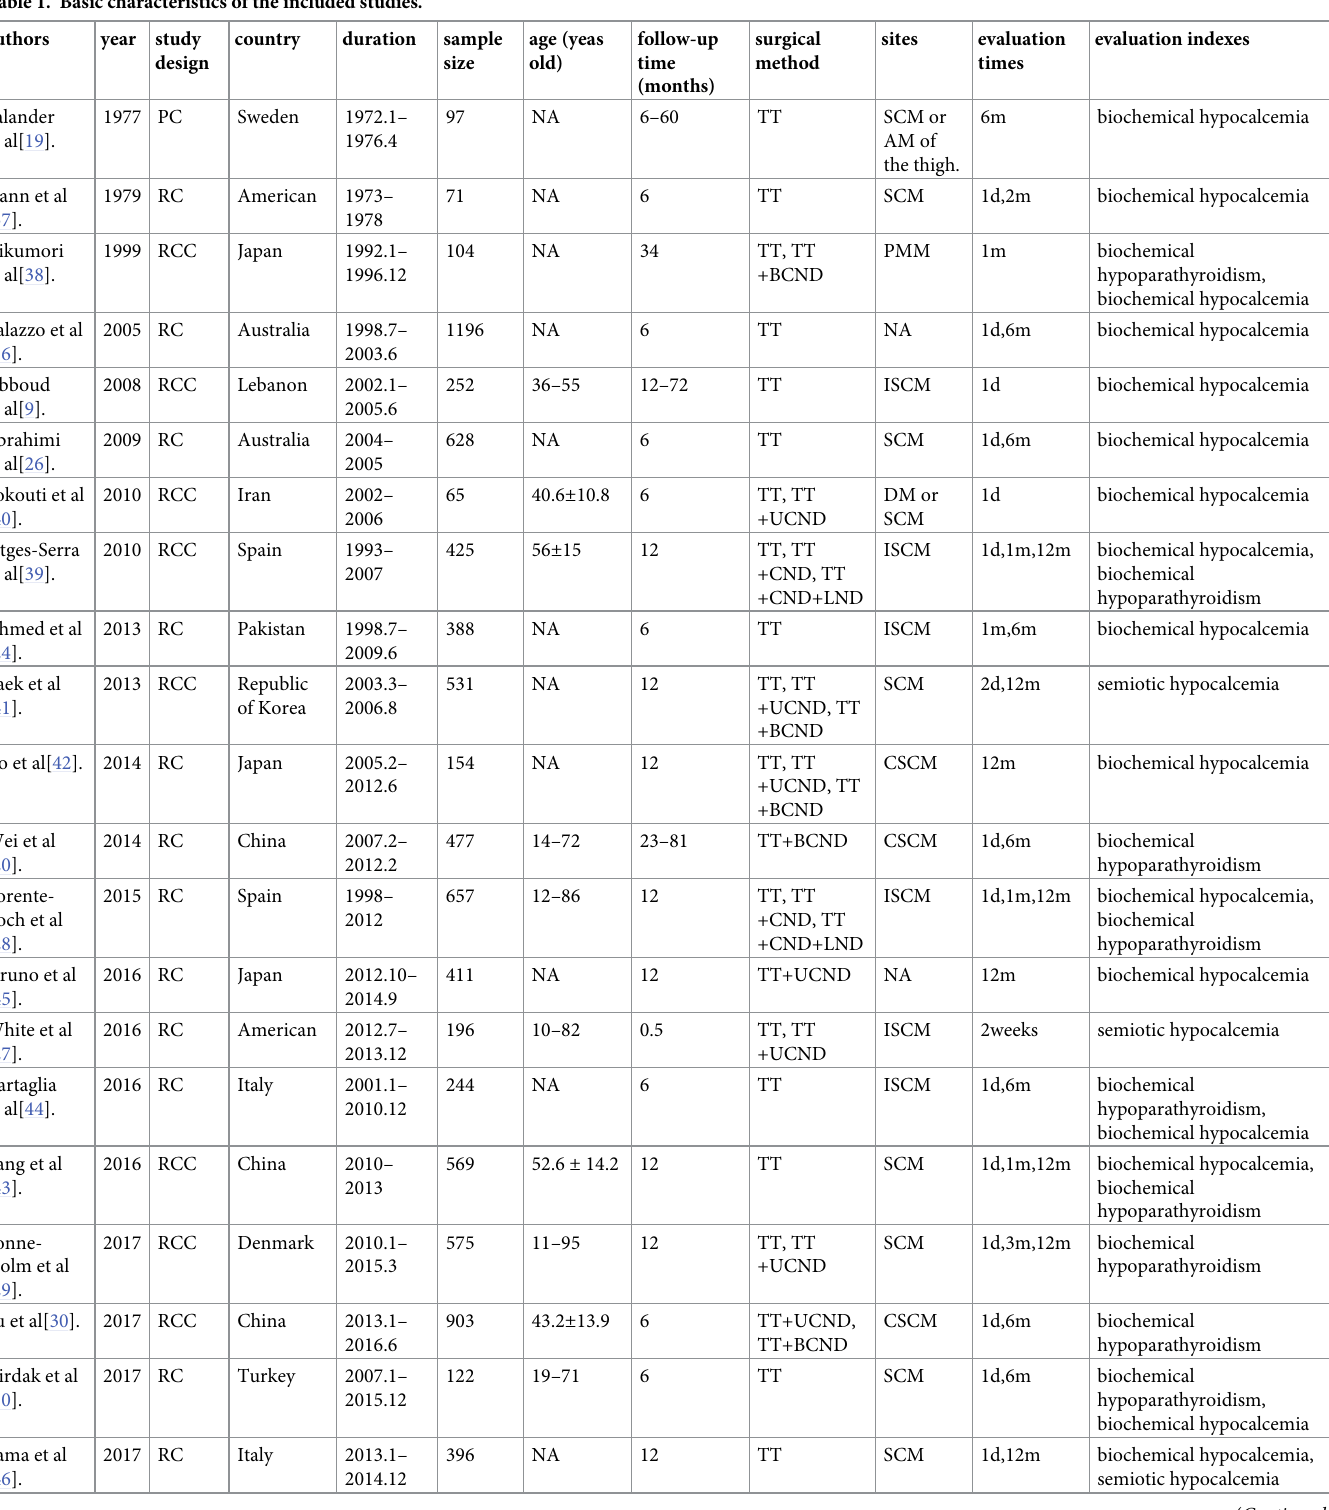
Table 1. Basic characteristics of the included